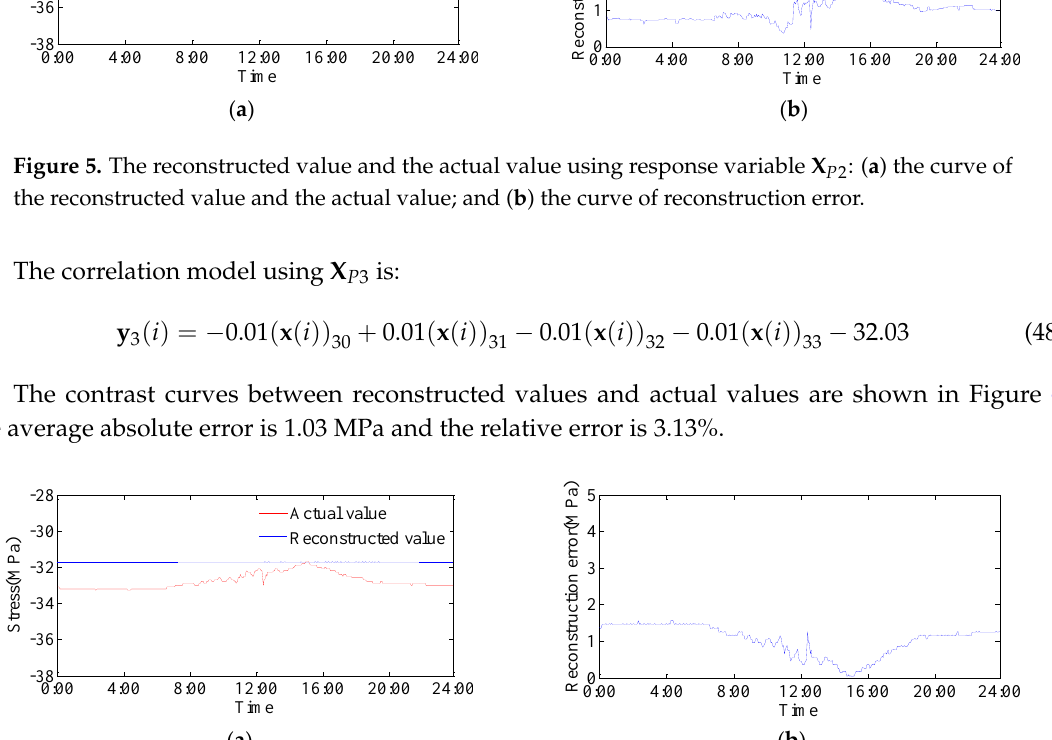
Figure 6. The reconstructed value and the actual value using response variable X P 3 : ( a ) the curve of the reconstructed value and the actual value; and ( b ) the curve of reconstruction error. The errors of the reconstructed information using different correlation coefficients of the response variables are summarized in Table 2. Table 2. The summarized errors using different response variables.